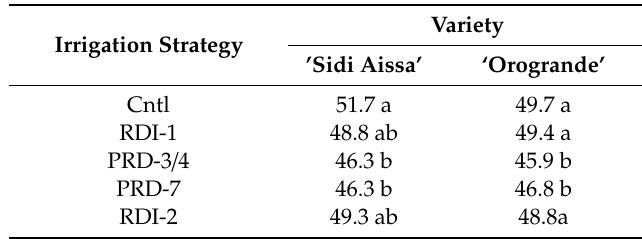
Table 7. E ff ect of irrigation strategies on juice content for ‘Sidi Aissa’ and ‘Orogrande’ clementine fruit at maturity (on 2 October 2017; in %).